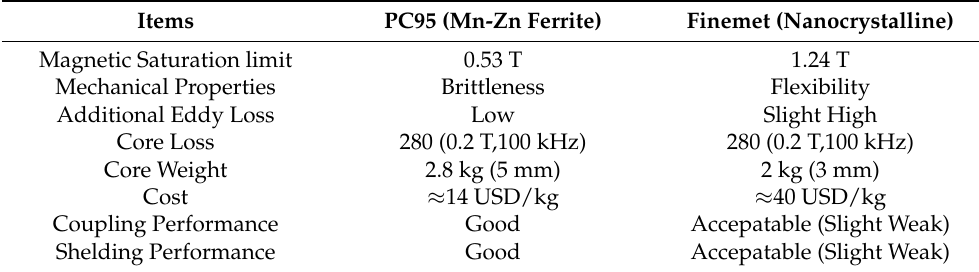
Table 10. A comparison of the characteristics of the EV-WPT system using TDK PC-95 Mn-Zn ferrite core and Hitachi Finemet nanocrystalline